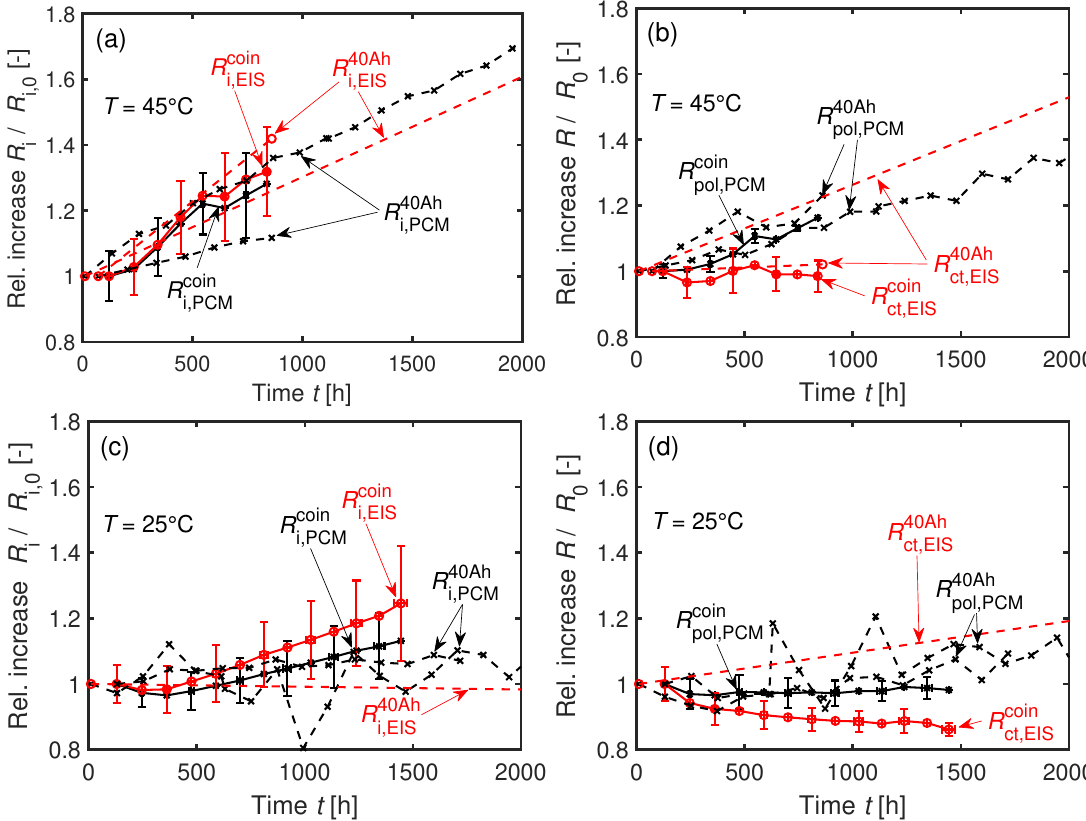
Figure 8. Developments of the ( a , c ) internal resistances, the ( b , d ) charge transfer, and polarization resistances during cyclic aging at 1C for the 40Ah cells and the averaged coin cells at ( a , b ) T = 45 ◦ C and at ( c , d ) T = 25 ◦ C. Each averaged coin cell curve consists of at least four cells. For better clarity, the error bars are only shown every 100